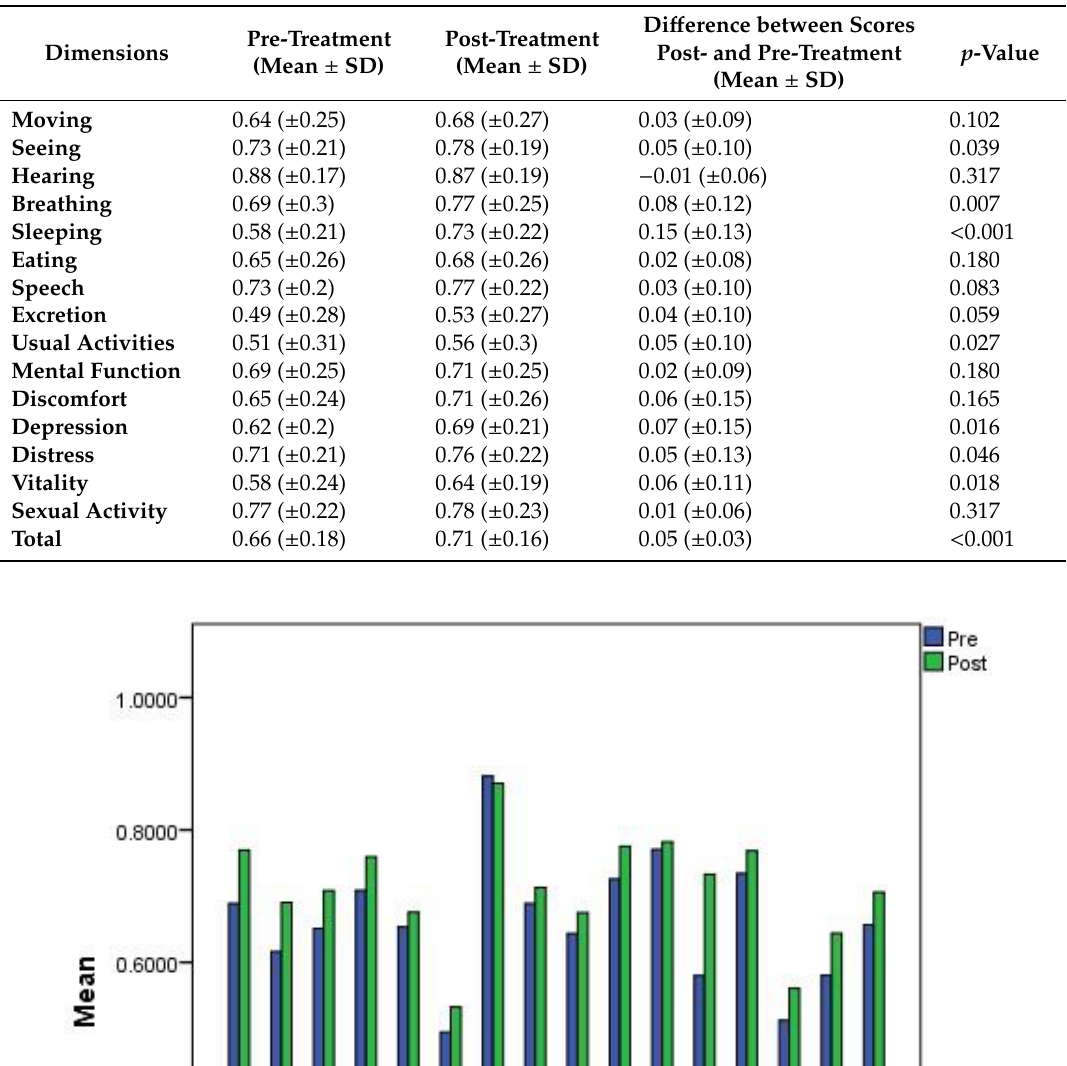
Table 3. Changes in quality of life (QoL) for MS patients before and after a new treatment.